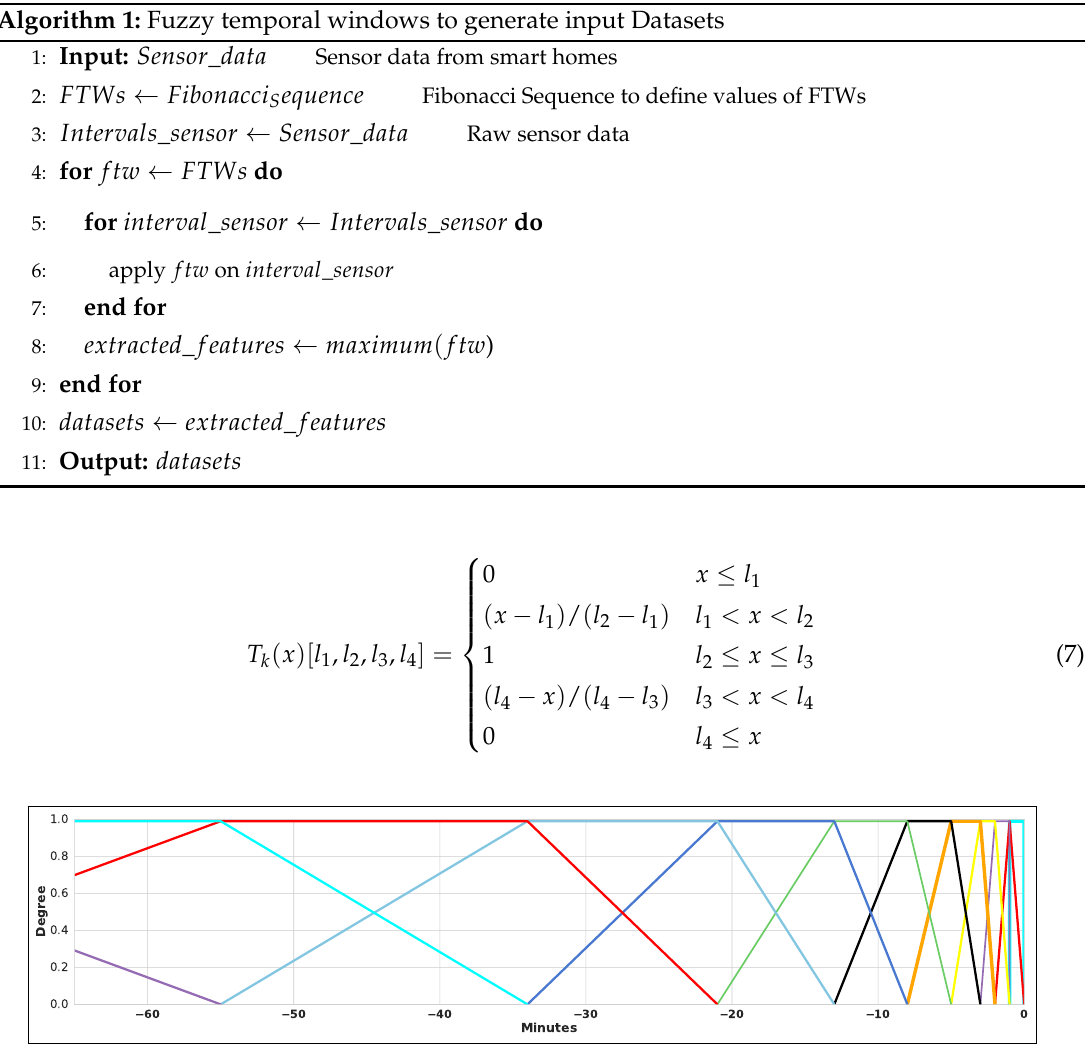
Figure 6. Example of multiple incremental fuzzy temporal windows to segment raw sensors